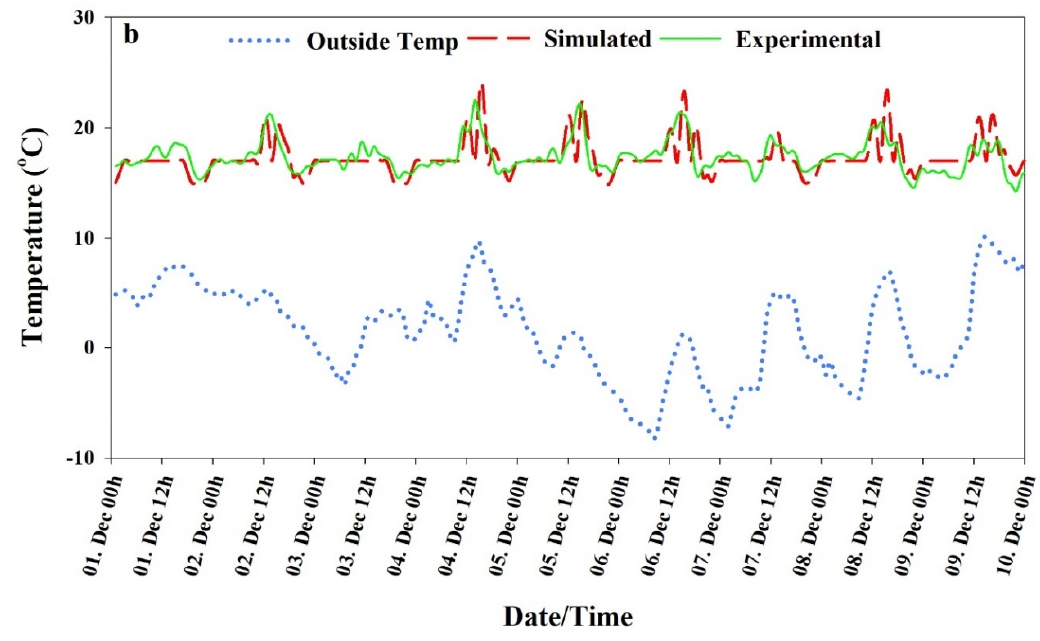
Figure 9. Computed versus measured internal air temperature of the greenhouse for validation. ( a ) summer conditions ( b ) winter conditions.